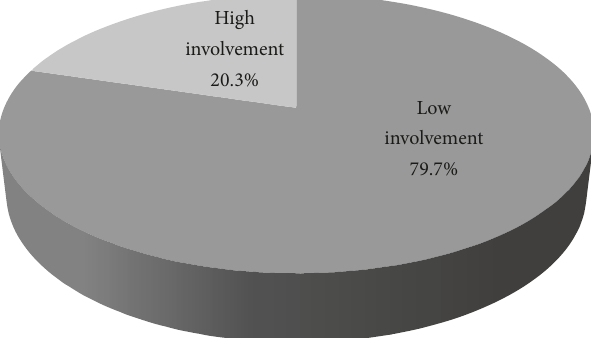
Figure 1: Overall level of men’s involvement in maternity